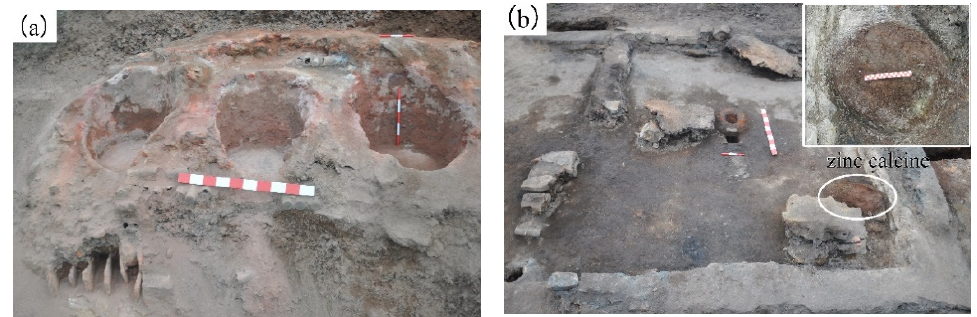
Figure 1. Archaeological evidence found in the Doulingxia site. ( a ) Cylindrical roasting hearths; ( b ) the unearthed zinc